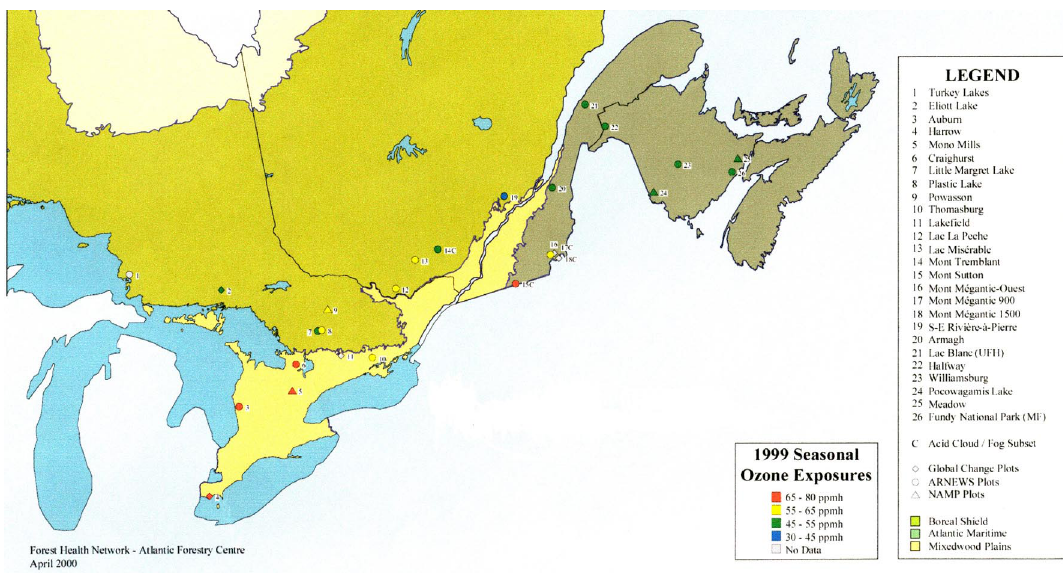
FIGURE 5. The locations of the forest plots in the transect used for the Forest Indicators of Global Change (FIGC) project of the Canadian Forest Service–Forest Health Network. This shows the categories for canopy ozone exposure for